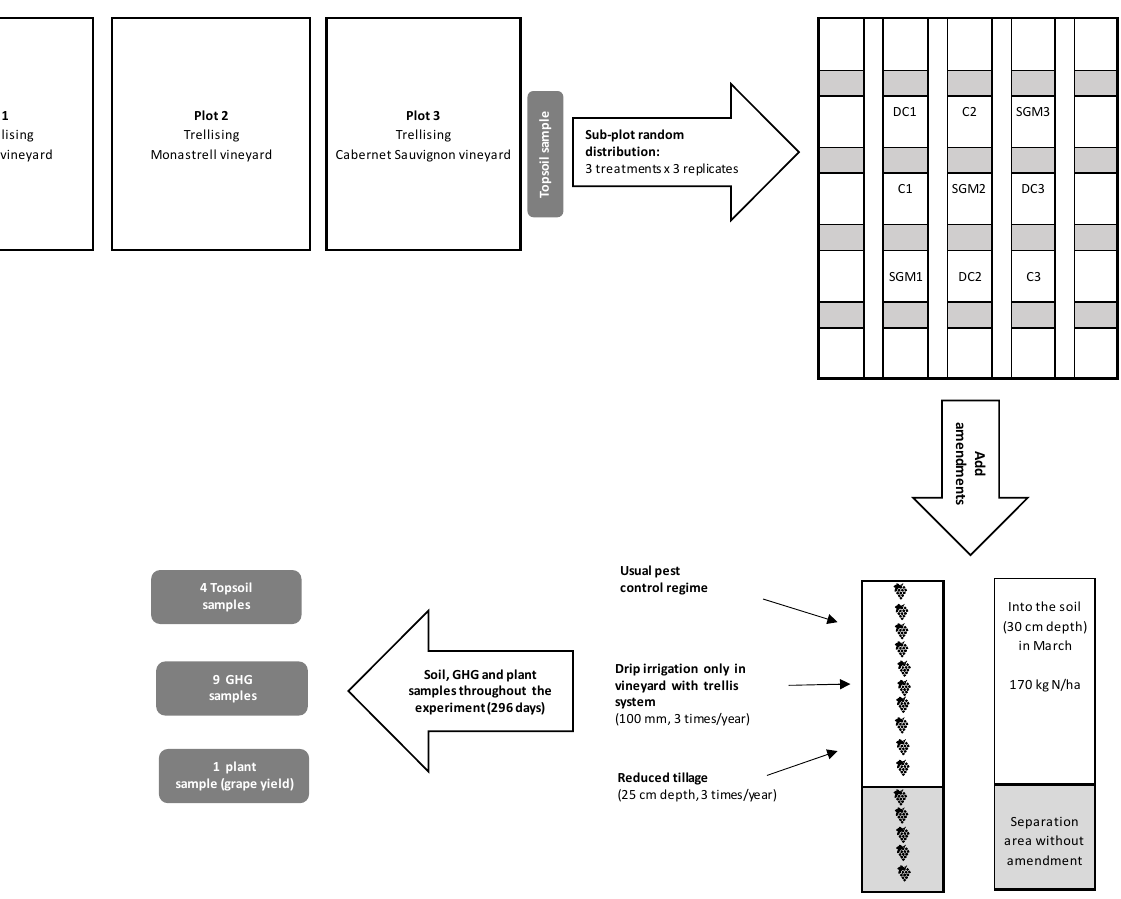
Figure 2. Scheme of the experimental design. (SGM: sheep/goat manure, DC: distillery organic waste compost, C: unfertilised control and GHG: greenhouse gas).